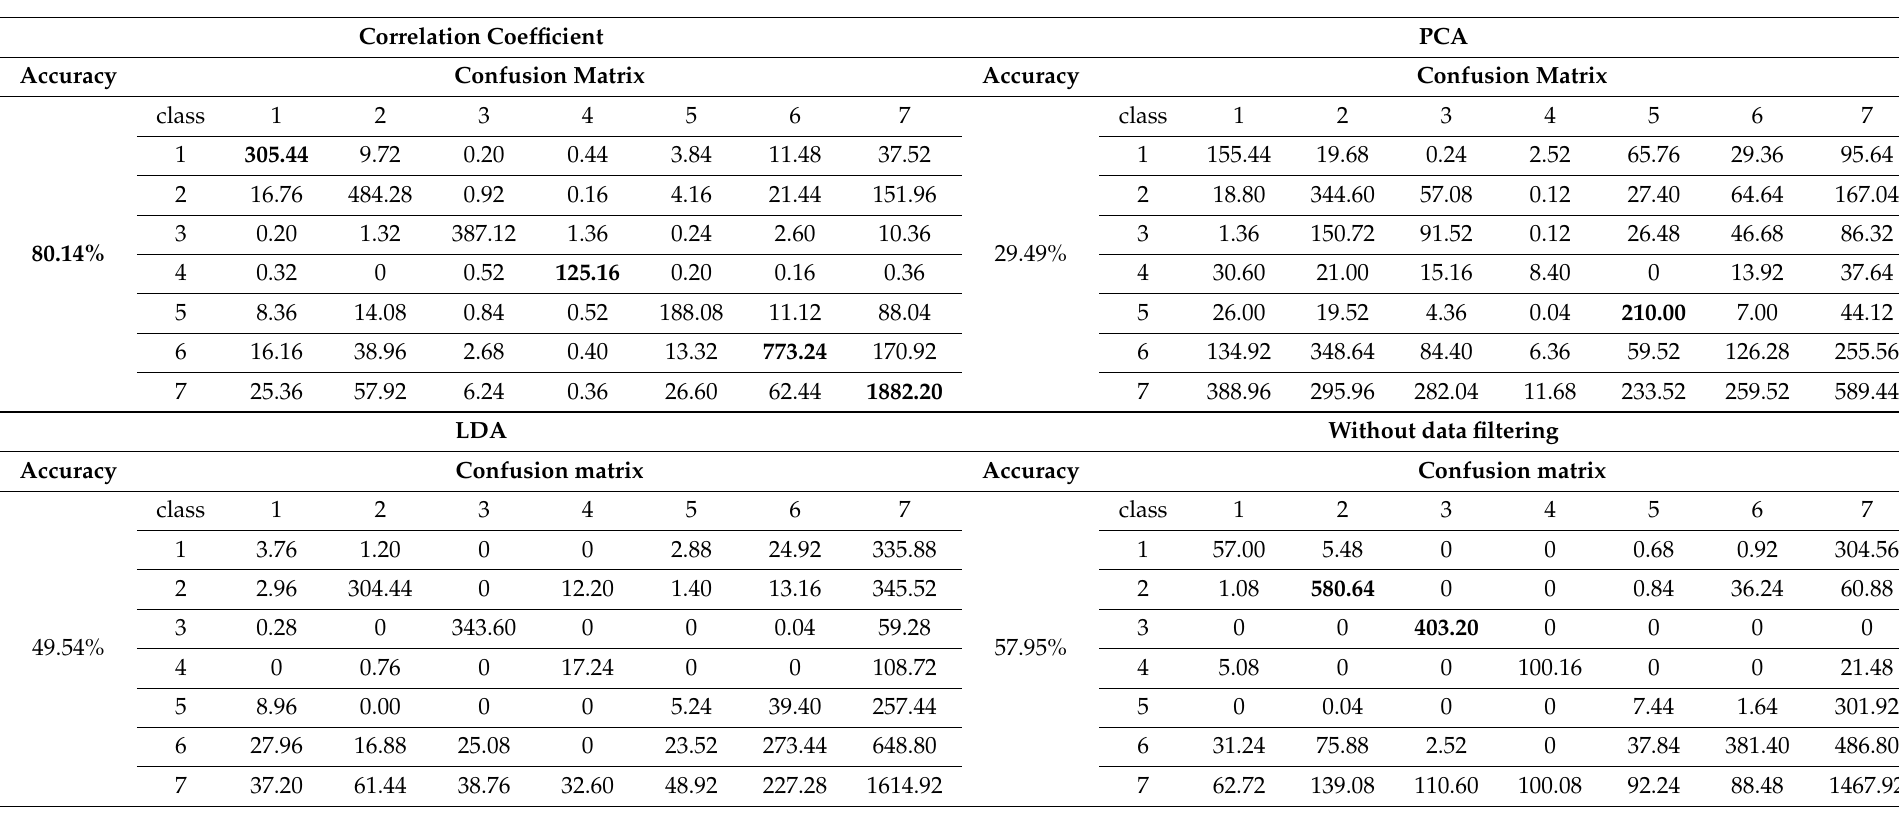
Table 3. A comparison of the algorithms using classification accuracy in percentage as a prototype for the events (1) frying canola oil on an electric hob, (2) frying olive oil on an